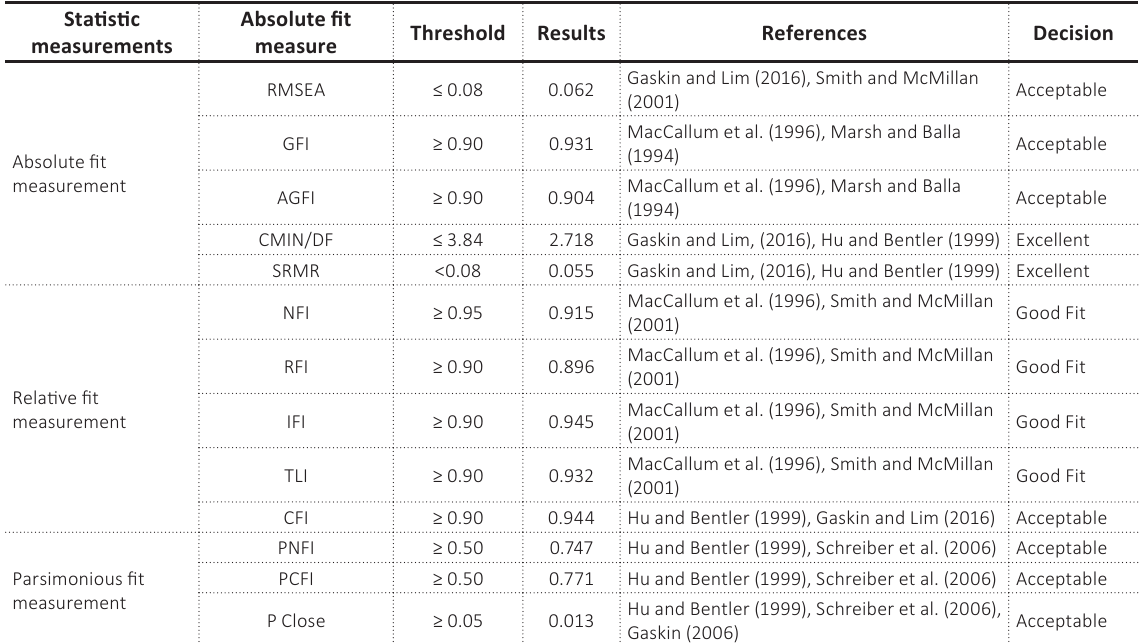
Table 4. Model fit indices